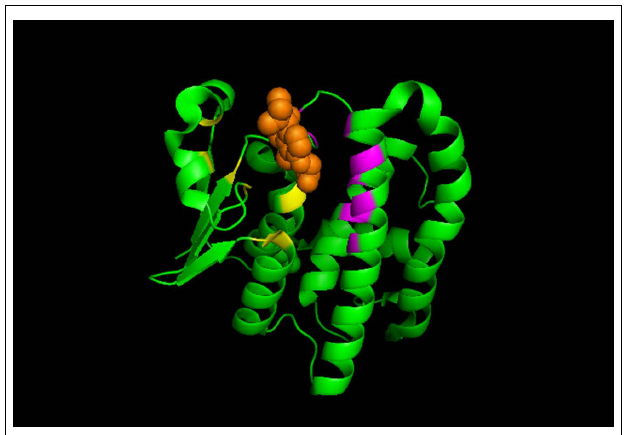
FIGURE 1 |A cartoon diagram of GSTP, a representative of a soluble GST enzyme. The N-terminal GSH-binding site (G-site, in yellow) and the C-terminal H-site (in purple) that binds the electrophilic substrate (in orange) are shown.